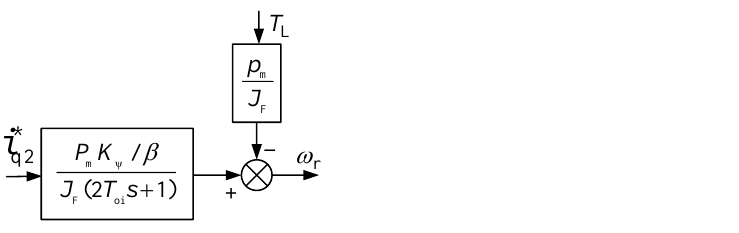
Figure 10. Simplified structure of a speed-loop-controlled object. * means the reference value.